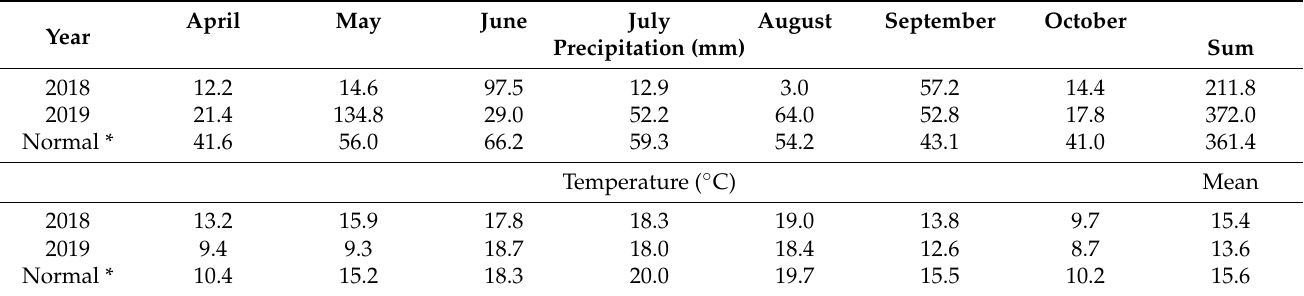
Table 2. Precipitation and temperature during the sugar beet vegetation.